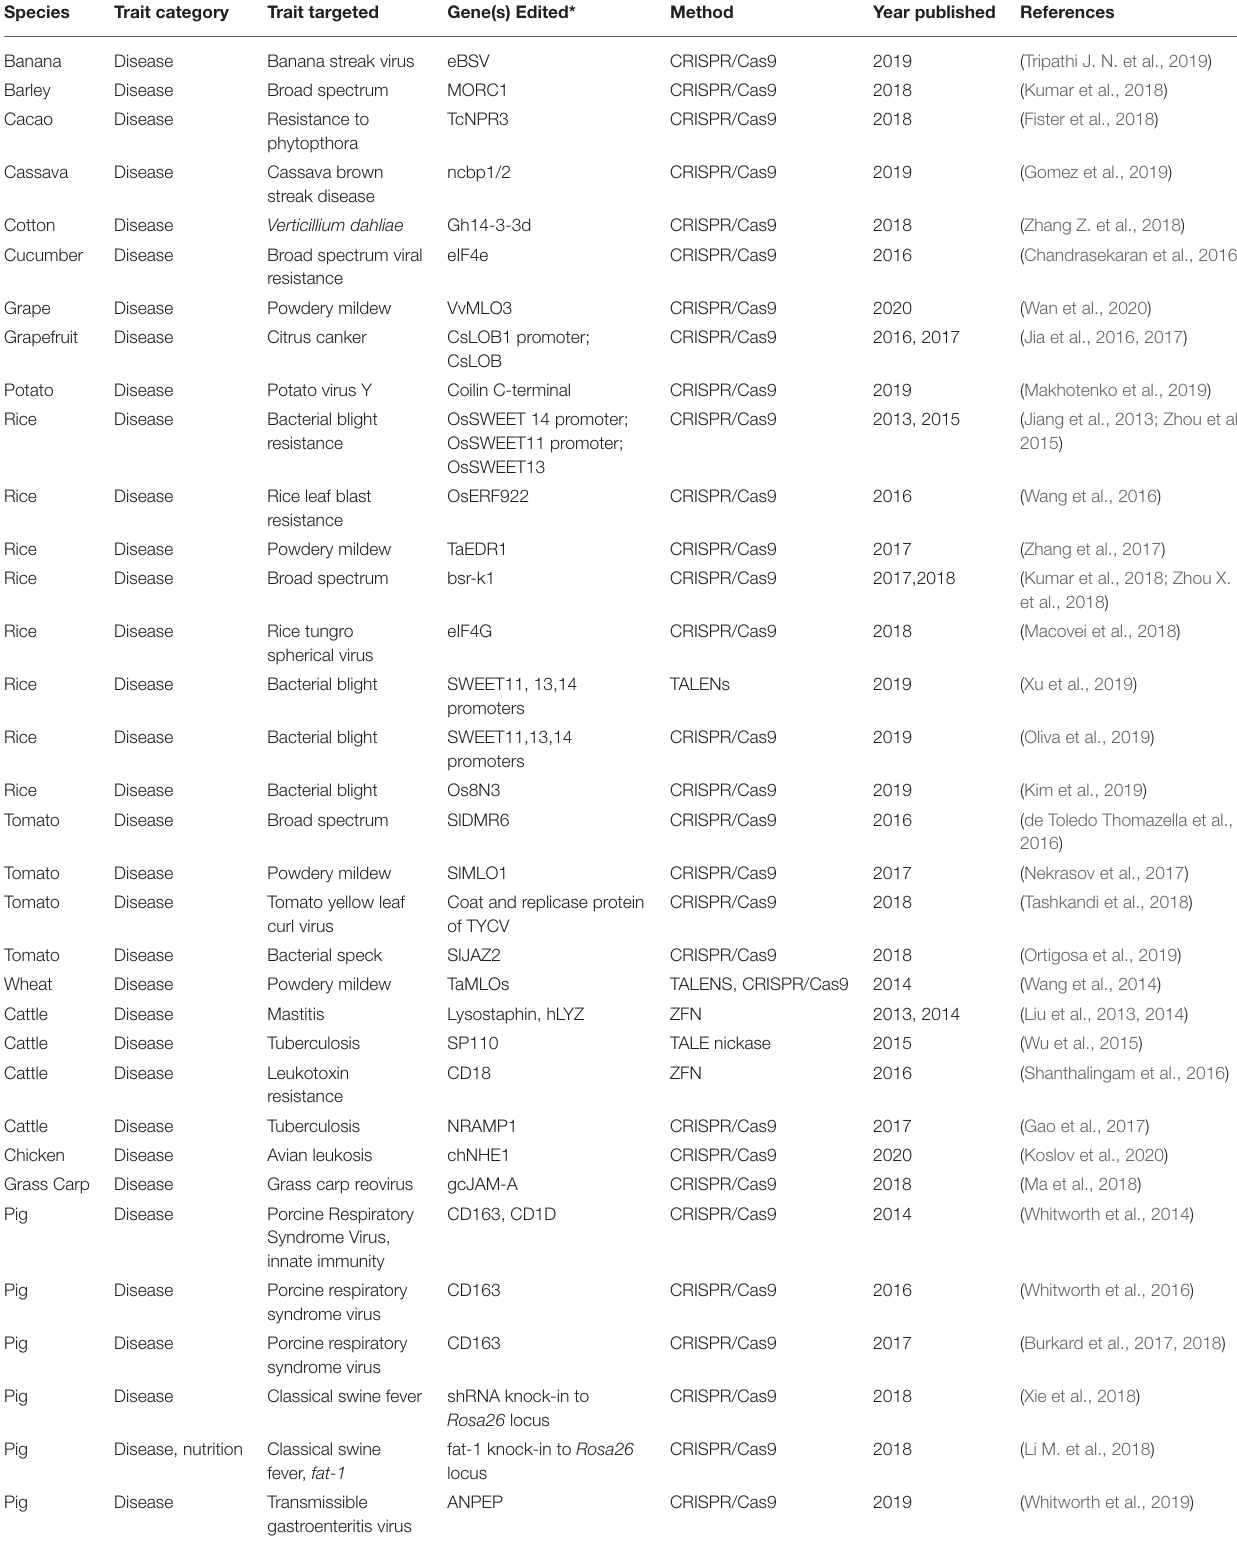
TABLE 2 | Summary of gene-editing applications for disease